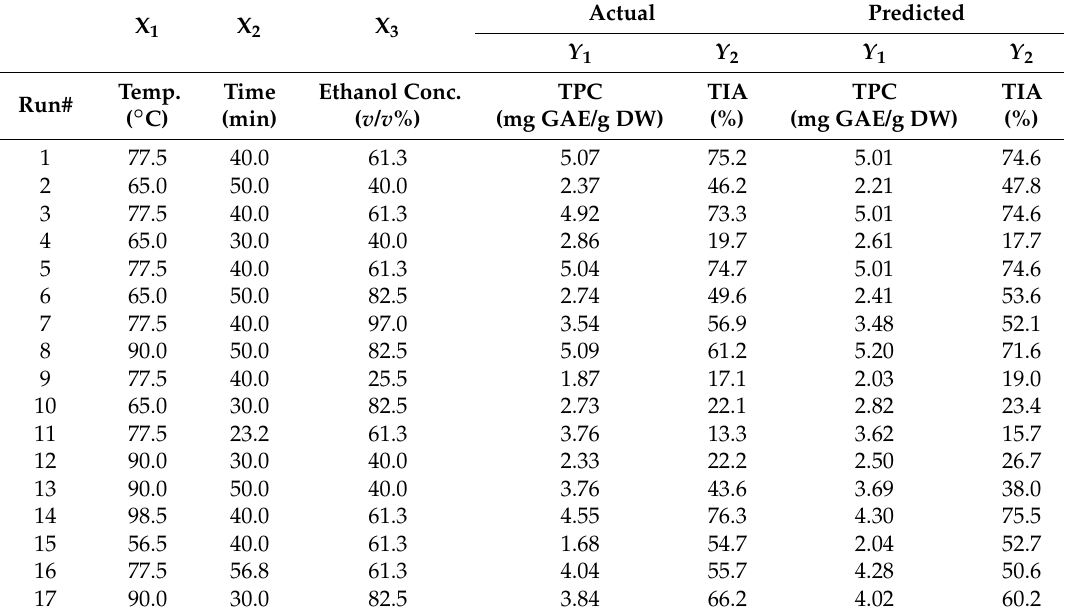
Table 2. Experimental runs of the central composite design and their responses, including actual and predicted values of total phenol compounds (TPC) and tyrosinase inhibition activity (TIA). Actual X 1 X 2 X 3